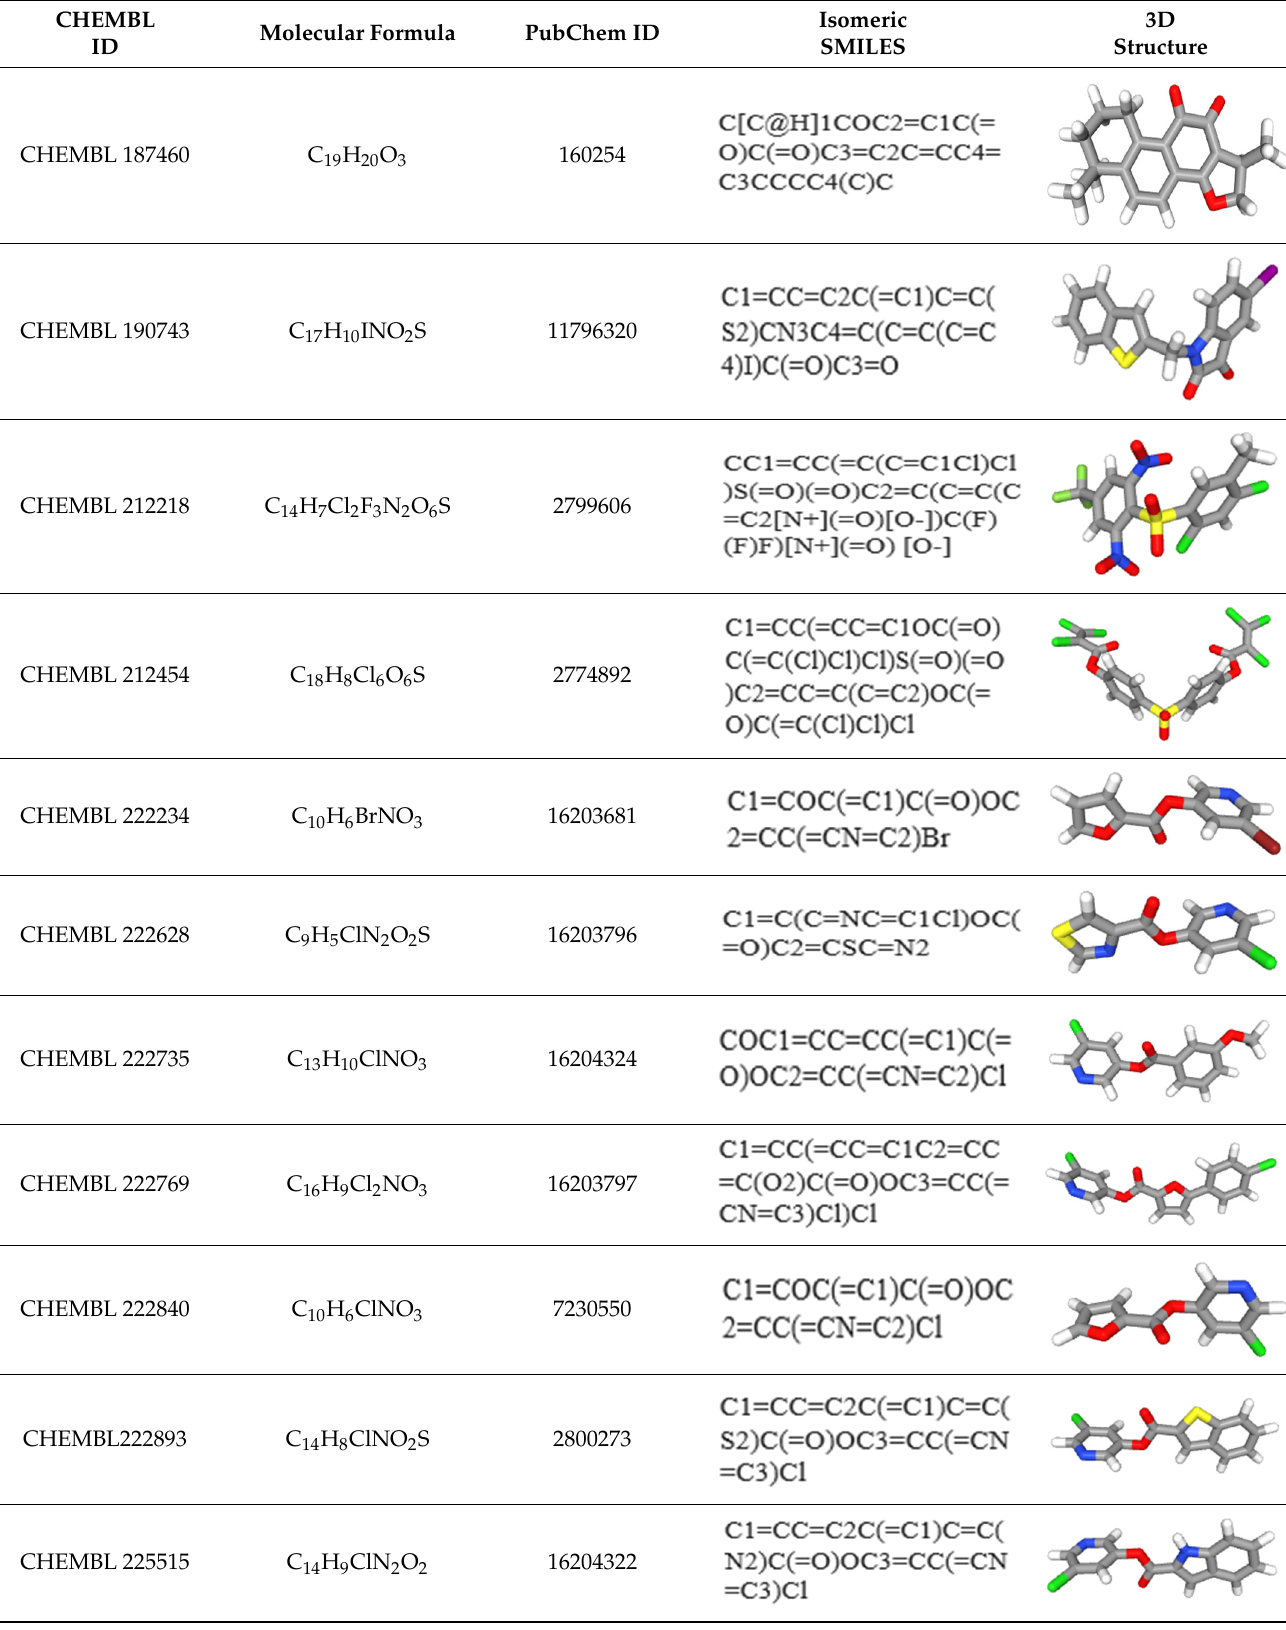
Table 2. Description of Fifteen Bioactive Molecules .